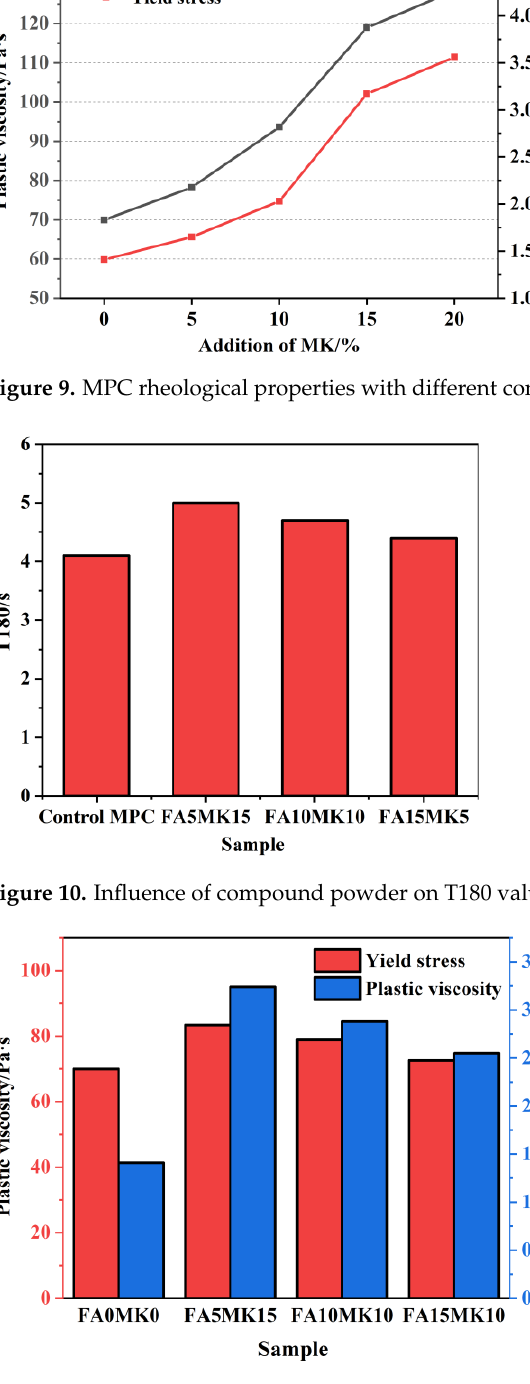
Figure 11. MPC rheological properties with addition of compound powder.